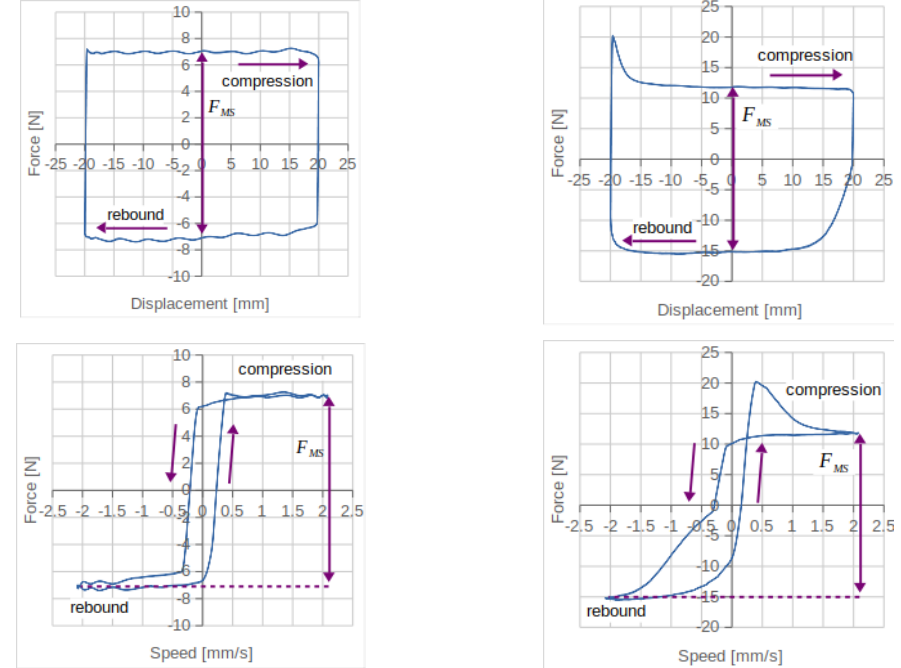
Figure 4. Representative force-displacement graphs ( top ) and force-speed graphs ( bottom ) of the single friction points piston/tube ( left ) and rod guide assembly/rod ( right ).